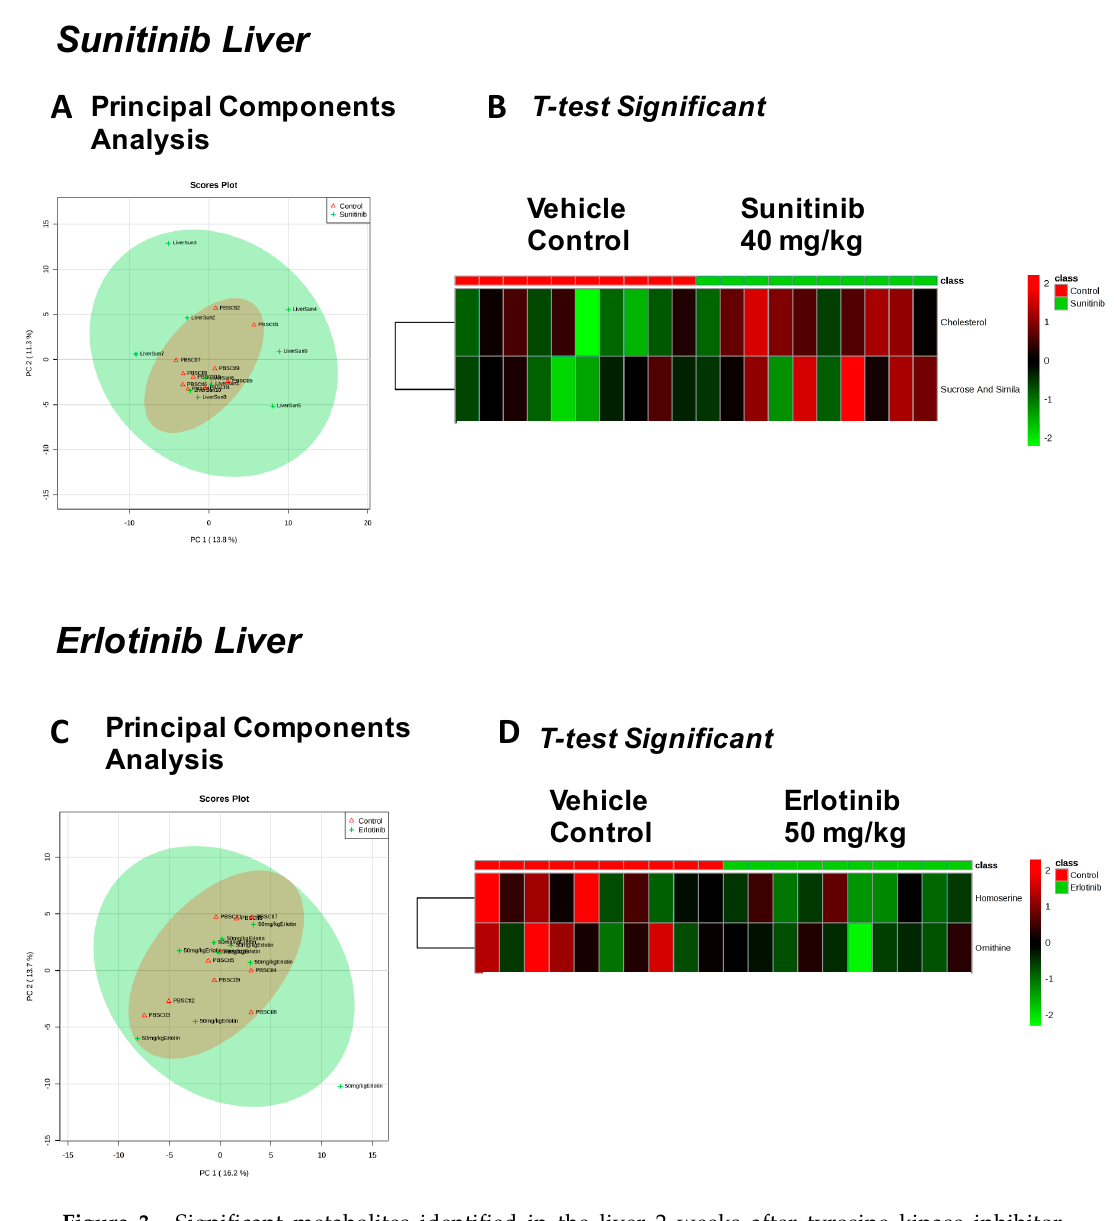
Figure 3. Significant metabolites identified in the liver 2 weeks after tyrosine kinase inhibitor (or vehicle control) treatment. PCA (principal components analysis) of metabolites identified in sunitinib-treated liver ( A ). t -test significant metabolites identified in sunitinib-treated liver ( B ). PCA (principal components analysis) of metabolites identified in erlotinib-treated liver ( C ). t -test significant metabolites identified in erlotinib-treated liver ( D ). N = 10/group